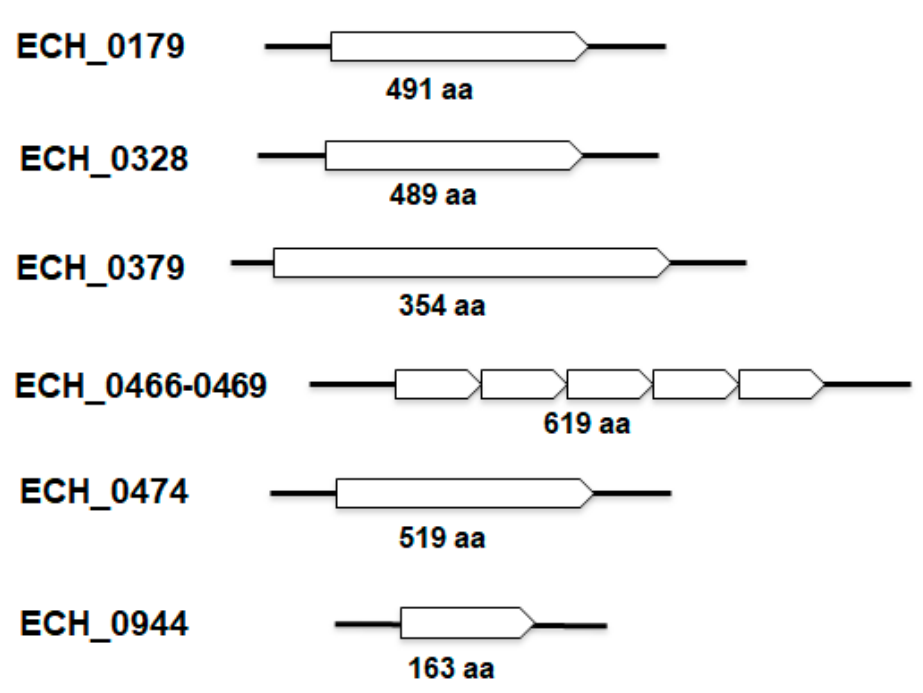
Figure 1. Antiporter genes identified from the E. chaffeensis genome. Gene names and GenBank accession numbers for the genome were included in Table 1.